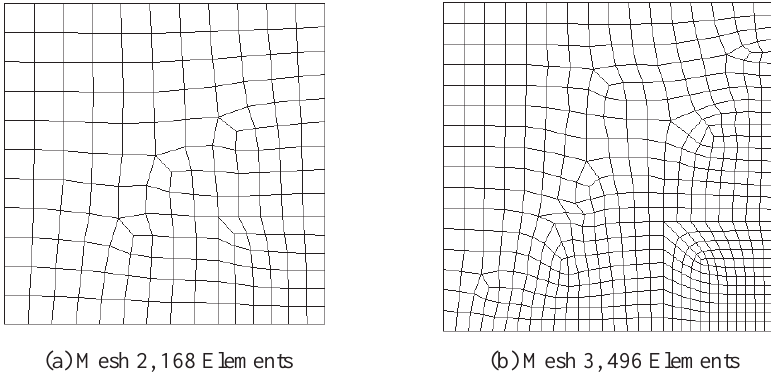
Fig. 11. Symmetric quadrant of a clamped square composite plate subjected to impact by a cylinder at the center of the plate.